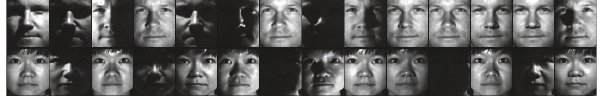
Figure 4: Example face images of two subjects from the Extended Yale B data